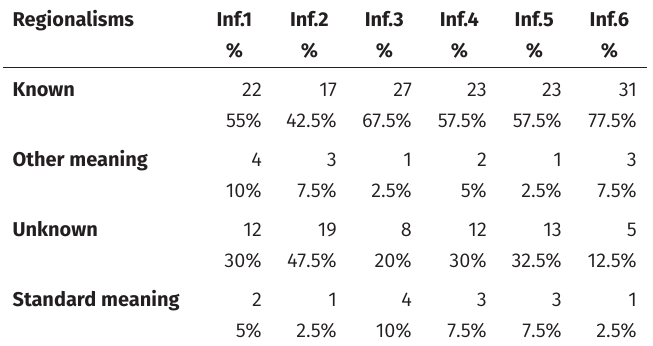
Table 3: Results from Machico.